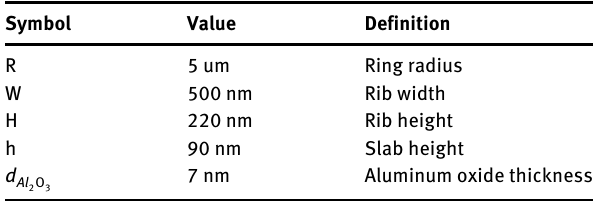
Table 1: Geometrical